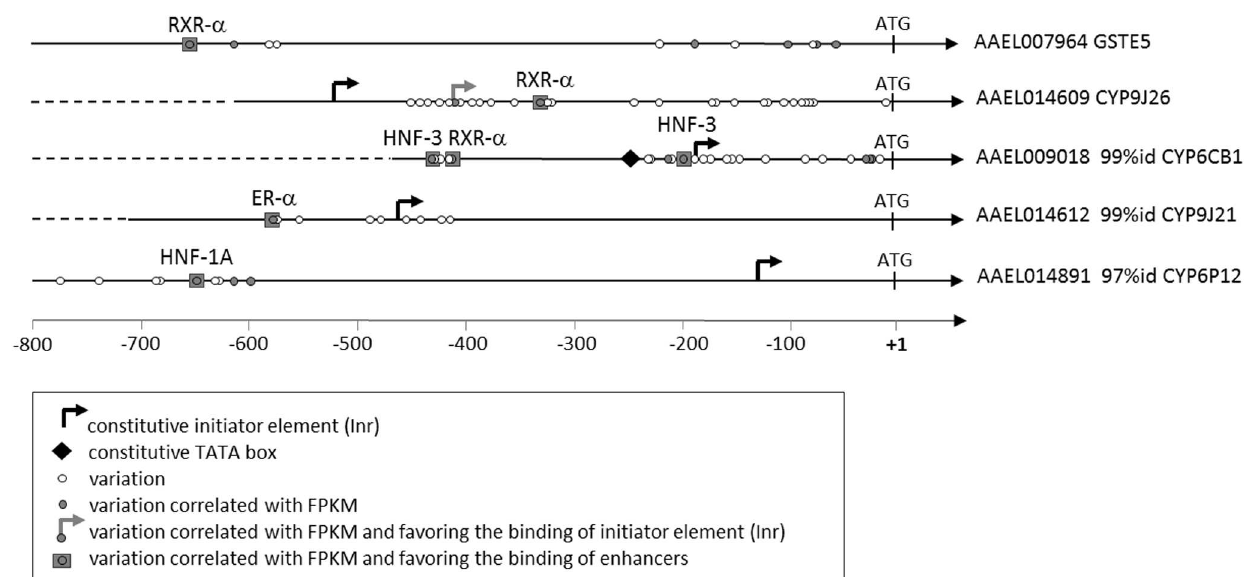
Fig 3. Promoter elements potentially associated with the up regulation of detoxification genes in resistantpopulations. Only variations correlated with transcription level and favouringthe bindingof potentialenhancer elementsare shown.Potentialinitiationsites (Inr) and TATA boxesare indicated.For each gene, variationsdetectedin the upstream regionare shownas empty and filleddots dependingon the significance of the correlation betweentheir allelefrequencyand genetranscription level.